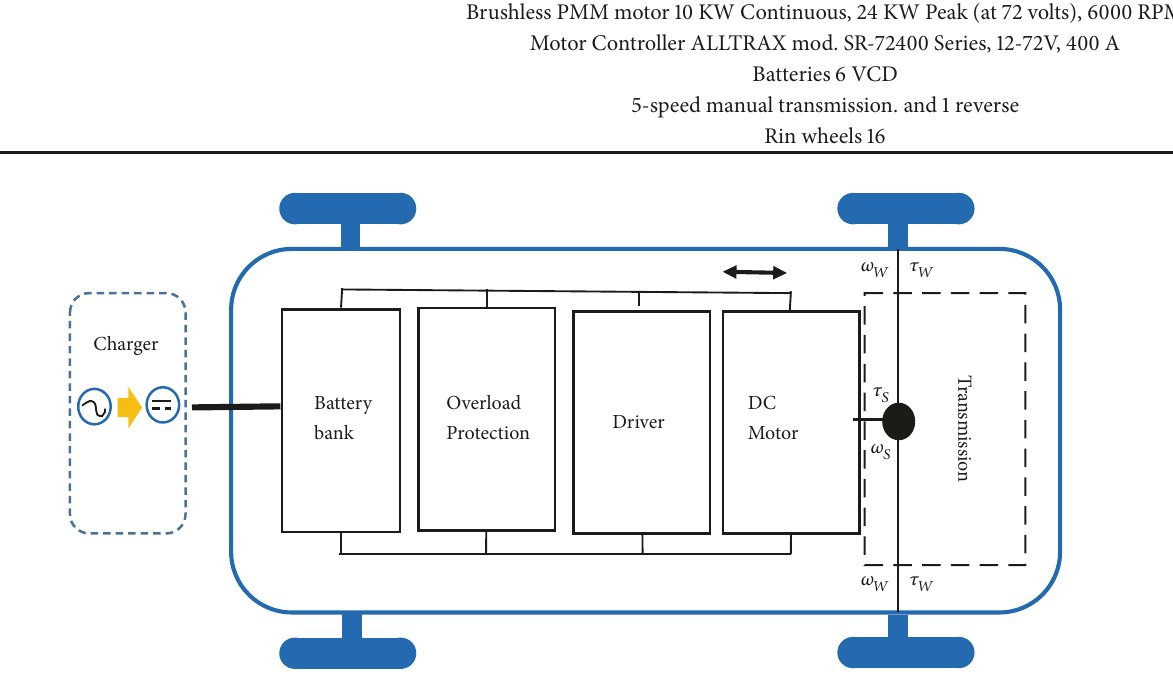
Figure 2: Main components of the